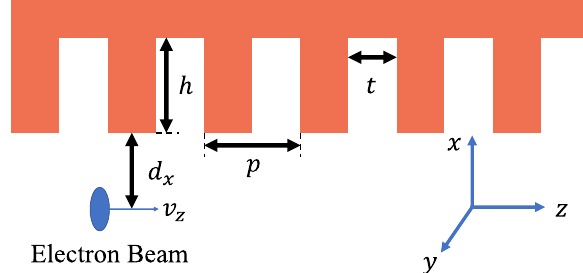
dogleg.FIG. 2. The setup of the horizontal single-jaw dechirper. In the LCLS beam line, the x – z plane is parallel to the ground. LCLS parameters of the dechirper setup are listed in Table